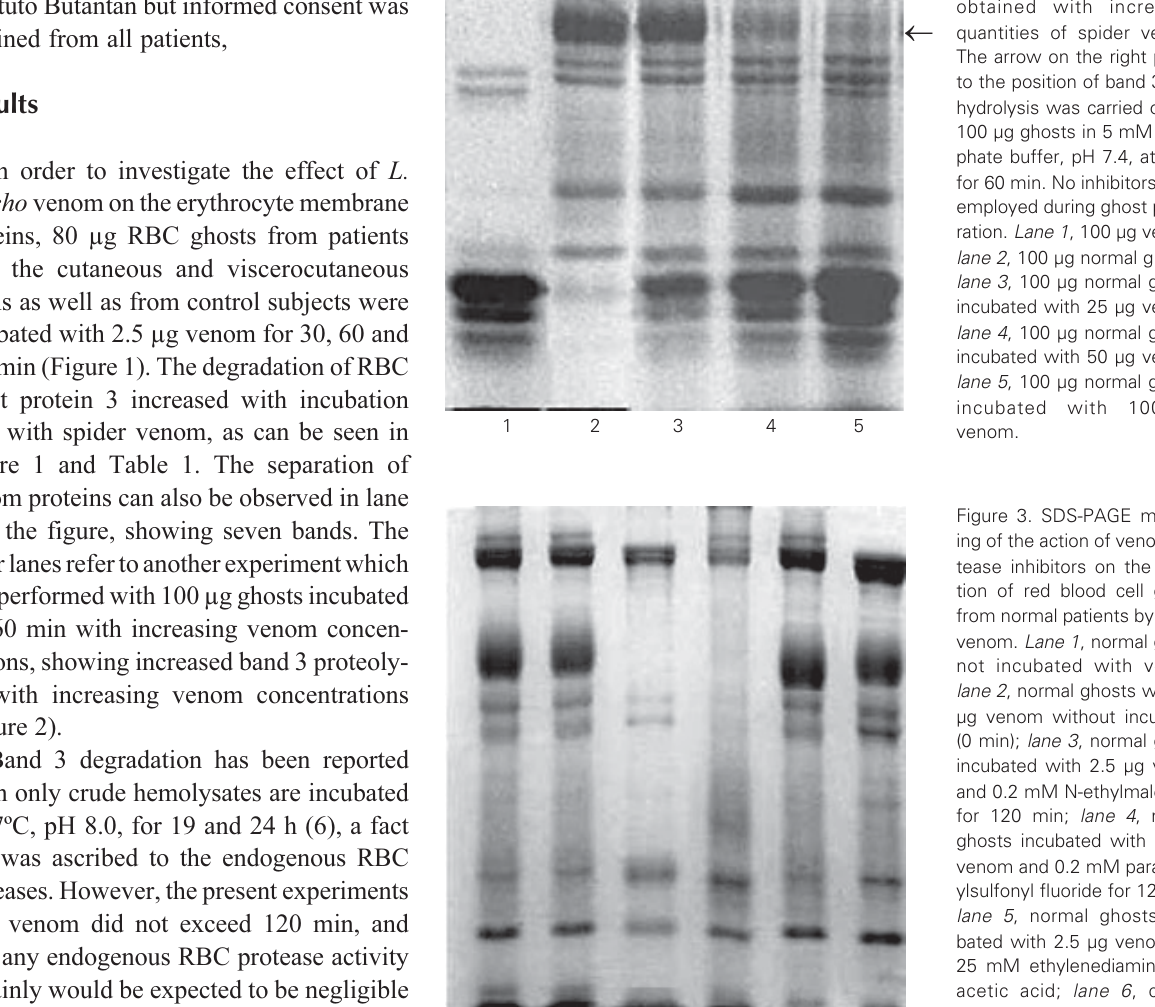
Figure 2. SDS-PAGE of the hy- drolysate of red blood cell ghosts from normal patients obtained with increasing quantities of spider venom. The arrow on the right points to the position of band 3. The hydrolysis was carried out on 100 µg ghosts in 5 mM phos- phate buffer, pH 7.4, at 37 o C for 60 min. No inhibitors were employed during ghost prepa-